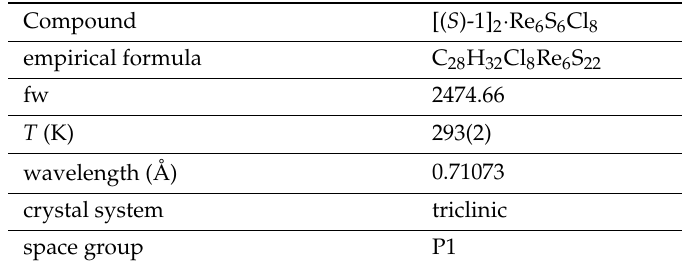
Table 2. Crystal Data and Structure Refinement for compound [( S )- 1 ] 2 ¨ Re 6 S 6 Cl 8